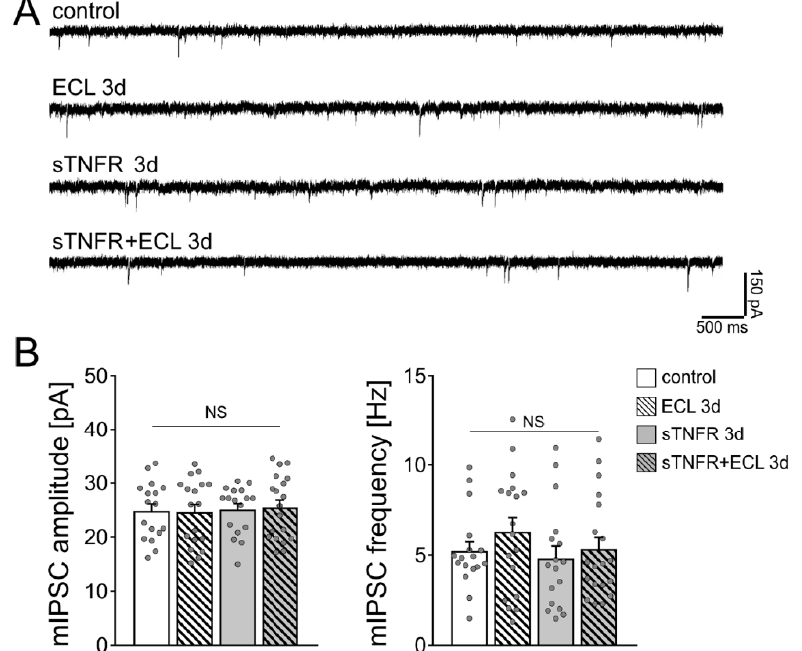
Figure 3. Scavenging TNF α with a soluble TNF receptor does not affect the strength of inhibitory synapses on dentate granule cells. ( A ) Sample traces of GABA receptor-mediated miniature inhibitory postsynaptic currents (mIPSCs) recorded from dentate granule cells of vehicle-only treated controls, denervated tissue cultures and tissue cultures treated with soluble TNF receptor (sTNFR, 10 µg/mL). ( B ) Group data of GABA receptor-mediated mIPSC recordings (untreated control, n = 17 cells from 5 cultures; untreated ECL 3d, n = 18 cells from 4 cultures; sTNFR 3d, n = 17 cells from 4 cultures; sTNFR + ECL 3d, n = 19 cells from 4 cultures; Kruskal –Wallis test followed by Dunn’s post hoc test; NS, non-significant difference).